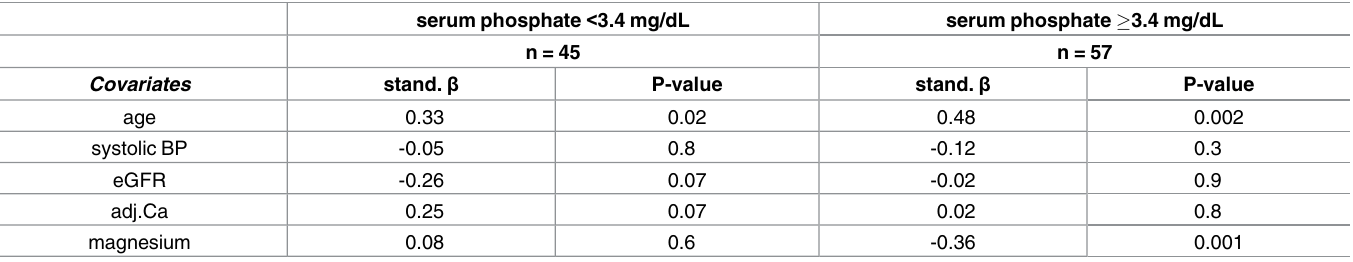
Table 3. Subgroup analyses for the association between exponential-transformed density of CAC and clinical